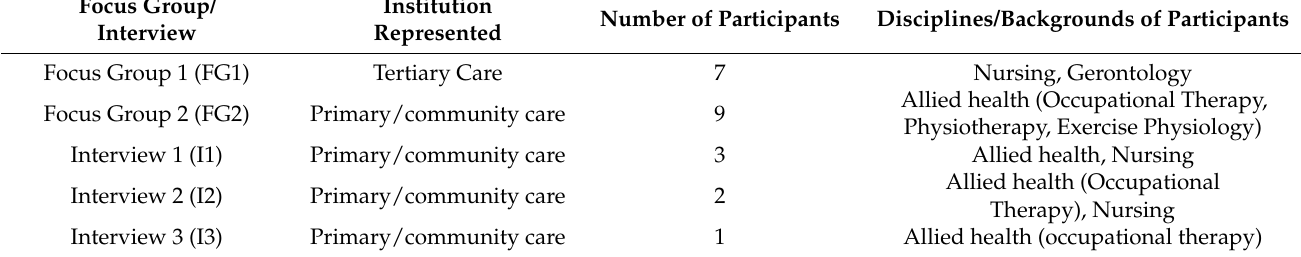
Table 2. Focus group and interview